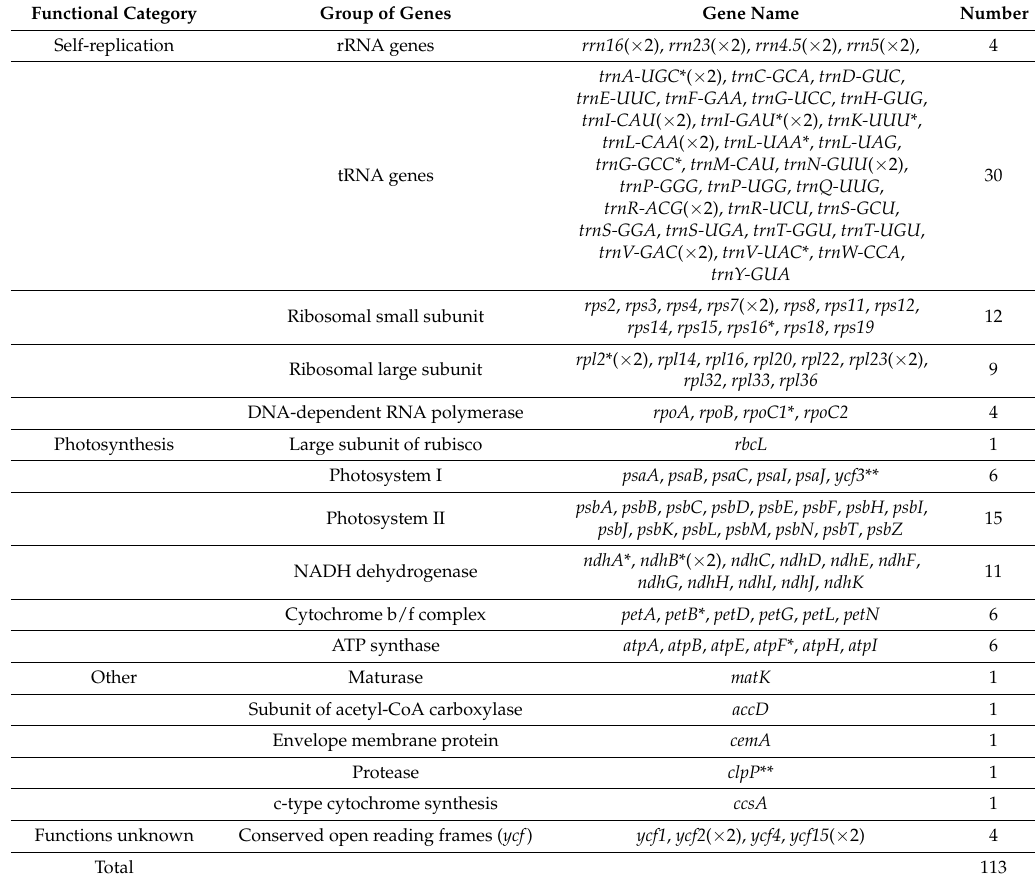
Table 1. List of genes found in Ailanthus altissima Chloroplast